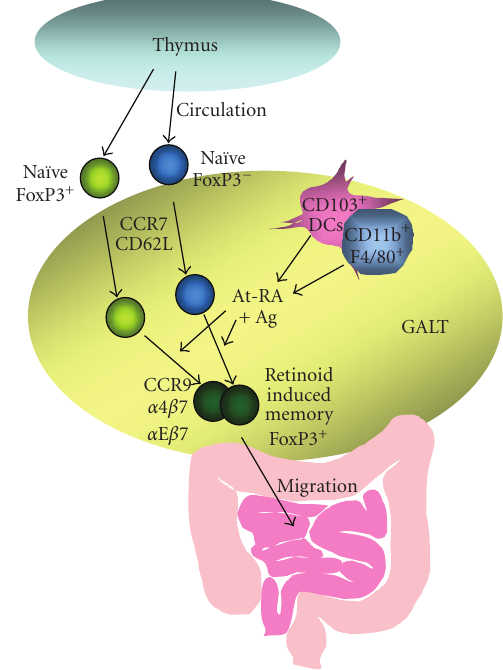
Figure 3: Induction and homing of retinoid-induced FoxP3 + T cells . Gut homing FoxP3 + T cells are made in gut-associated lymphoid tissues (GALT) but not in the thymus. FoxP3 + T cells made in the thymus have the na¨ıve T cell phenotype in expression of homing receptors and migrate to secondary lymphoid tissues. In the pres- ence of retinoic acid, these na¨ıve FoxP3 + T cells become gut homing memory FoxP3 + T cells. Also, na¨ıve FoxP3 − T cells become FoxP3 + T cells in the GALT to become gut homing FoxP3 + T cells. These FoxP3 + T cells express CCR9 and α 4 β 7 among other tra ffi cking re- ceptors and are highly e ffi cient in migration to the small intestine. The di ff erentiation of these T cells into gut homing FoxP3 + T cells is mediated by subsets of dendritic cells and macrophages because they can present antigens and produce retinoic acid. Additionally, the epithelial cell interacting adhesion molecule α E β 7 is upregulated on FoxP3 + T cells if the tissue microenvironments have high levels of TGF- β 1. Intestine is such a tissue site that produces both retinoic acid and TGF- β